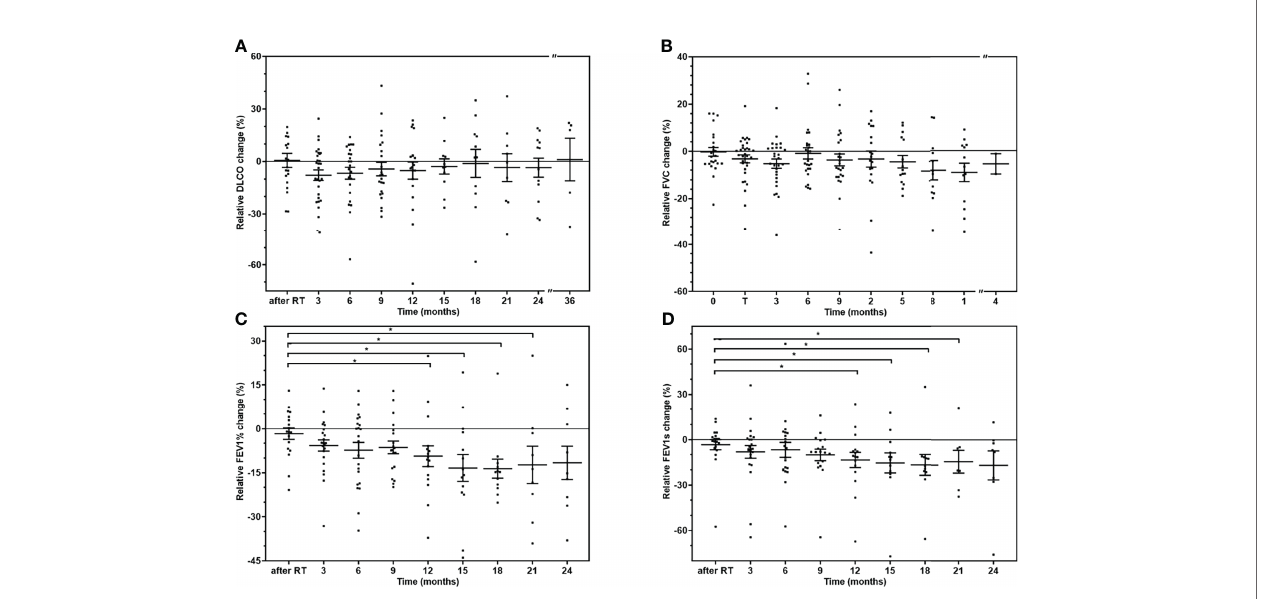
FIGURE 2 | The relative change of the pulmonary function tests of the patients. The individual values and mean (± SD) of pulmonary function tests at different time points. (A) Relative DLCO change. (B) Relative FVC change. (C) Relative FEV1% change. (D) Relative FEV1 change. The pulmonary function changes are compared with the value directly after radiotherapy with Mann-Whitney U test (* p <